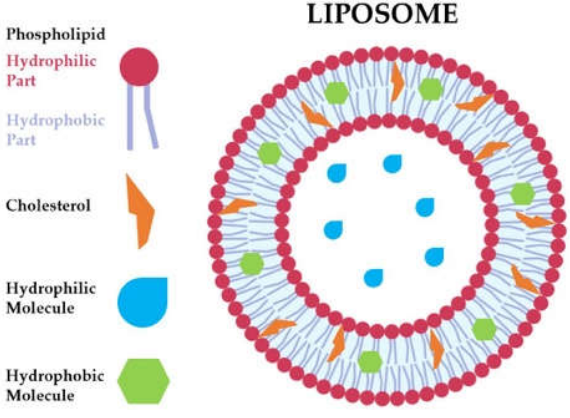
Figure 1. Schematic representation of liposome structure. Liposomes resemble extracellular vesicles (EVs), the lipid bilayer-delimited